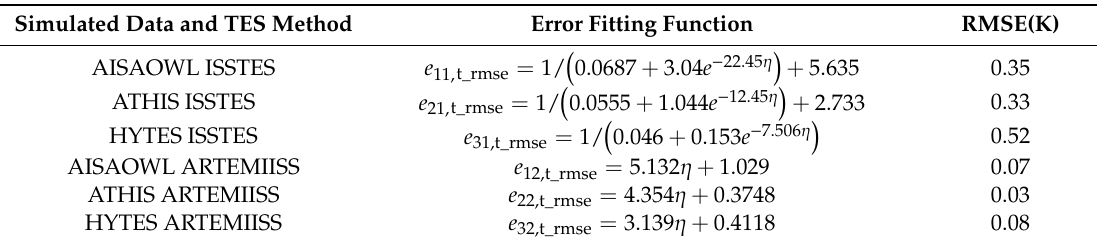
Table 13. The LST error fitting function about NEDT when center wavelength shift ratio = − 0.05 and FWHM change ratio = 0.